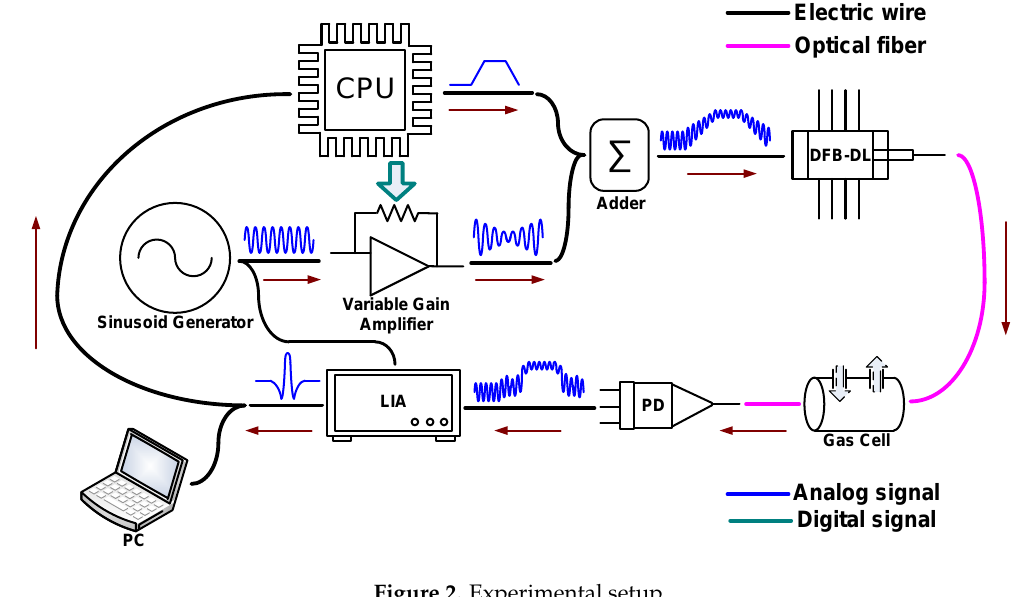
Figure 2. Experimental setup.